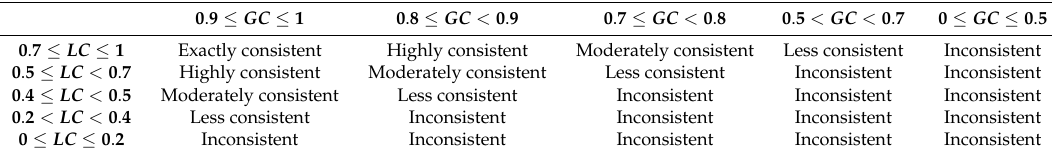
Table 1. Definition of degrees of